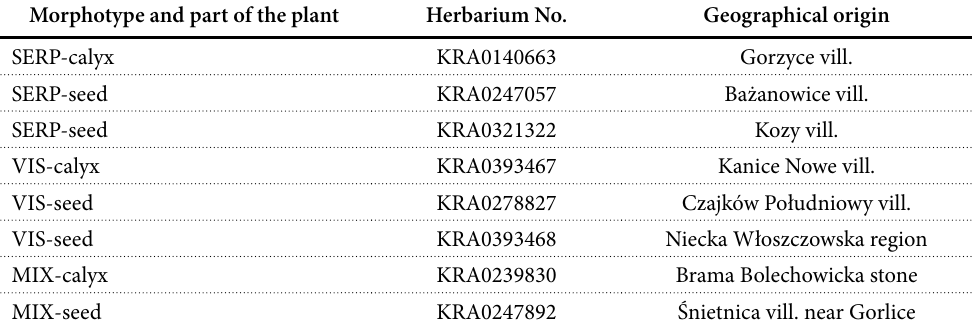
Tab. 2 Samples of Arenaria serpyllifolia s. l. included in SEM observation.